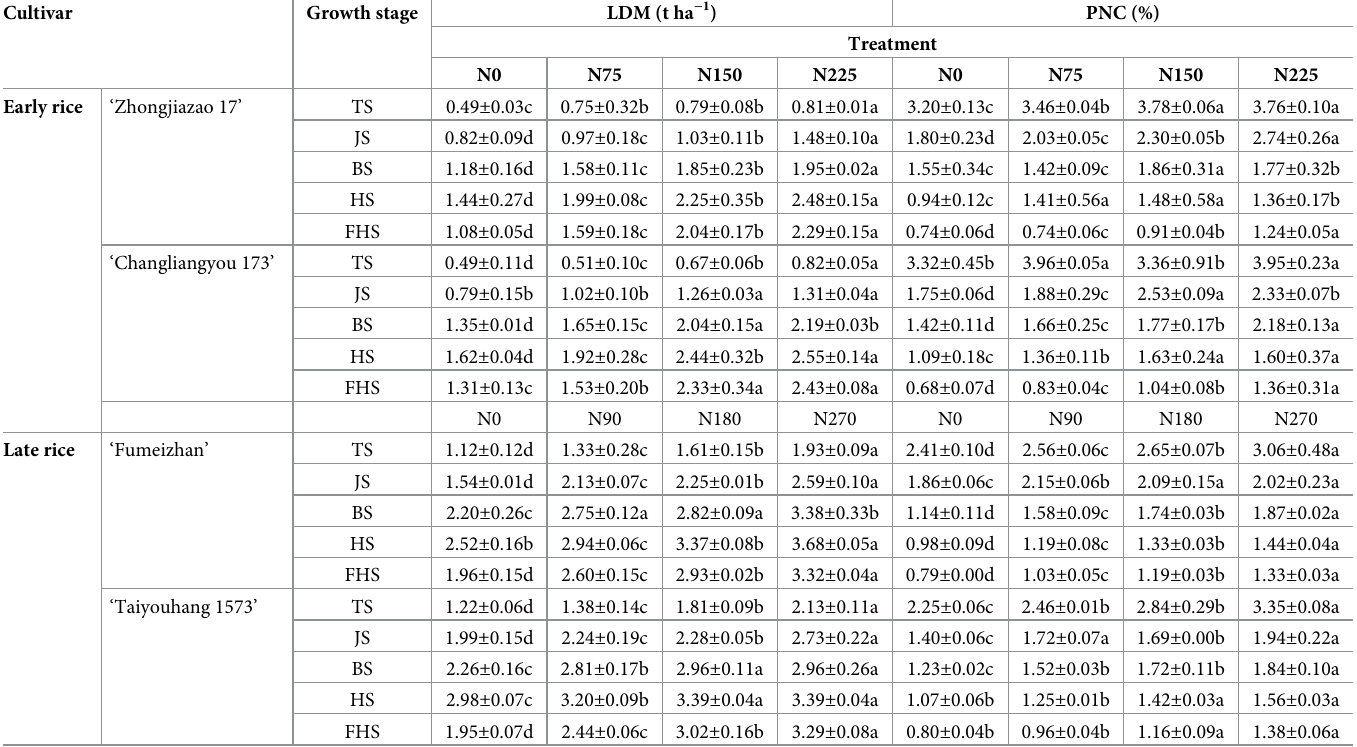
Table 2. Dynamic changes in leaf dry matter and leaf nitrogen concentration of rice under different nitrogen application